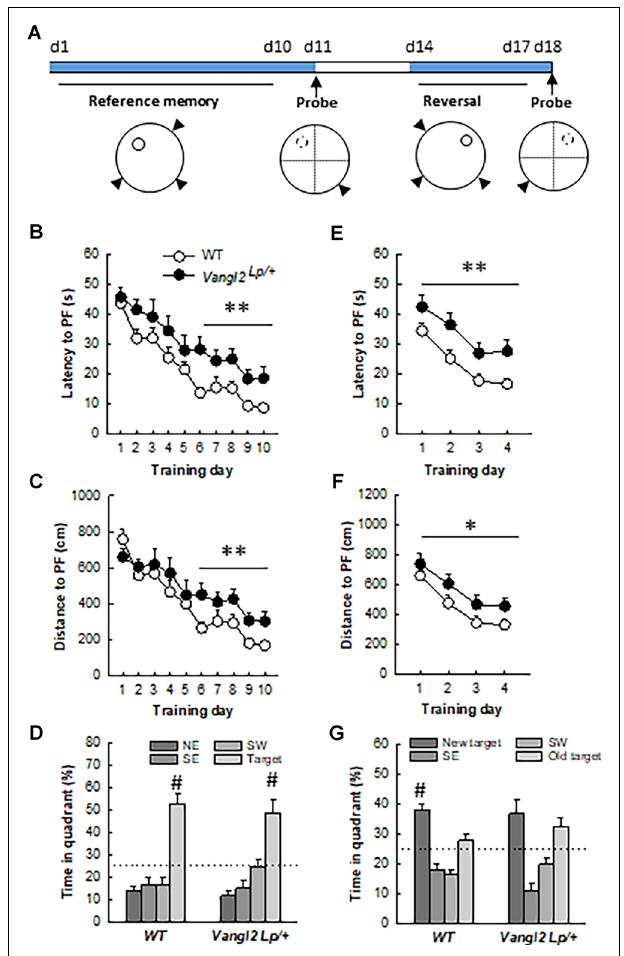
FIGURE 4 | Vangl2 lp mutation increases vulnerability to age-related decline in memory. (A) Timeline of the experiment. (B) Latency to find a hidden platform in a reference memory protocol. (C) Distance to find a hidden platform in a reference memory protocol. (D) Percentage of time spent in each quadrant of the water maze during the probe test. (E) Latency to find a hidden platform in a reversal protocol. (F) Distance to find a hidden platform in a reversal protocol. (G) Percentage of time spent in each quadrant of the water maze during the second probe test. White dots, WT n = 18 mice; Black dots, Vangl2 Lp/+ n = 11 mice. WT different from Vangl2 Lp/+ at ∗ p < 0.05, ∗∗ p < 0.01. # Different from all other positions, NK p < 0.01 for all